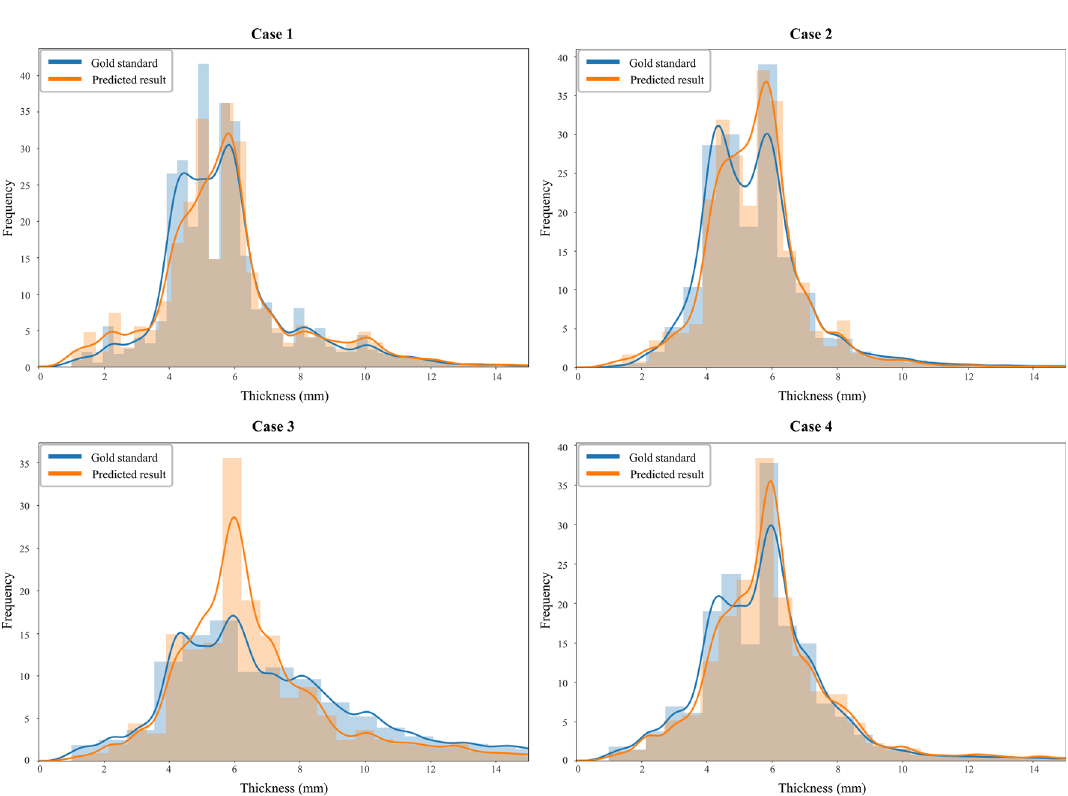
Figure 7. Distribution graphs of the cortical bone thickness from four randomly selected test cases over 50 experiments. The blue and orange curves were obtained from the gold-standard and segmentation results,